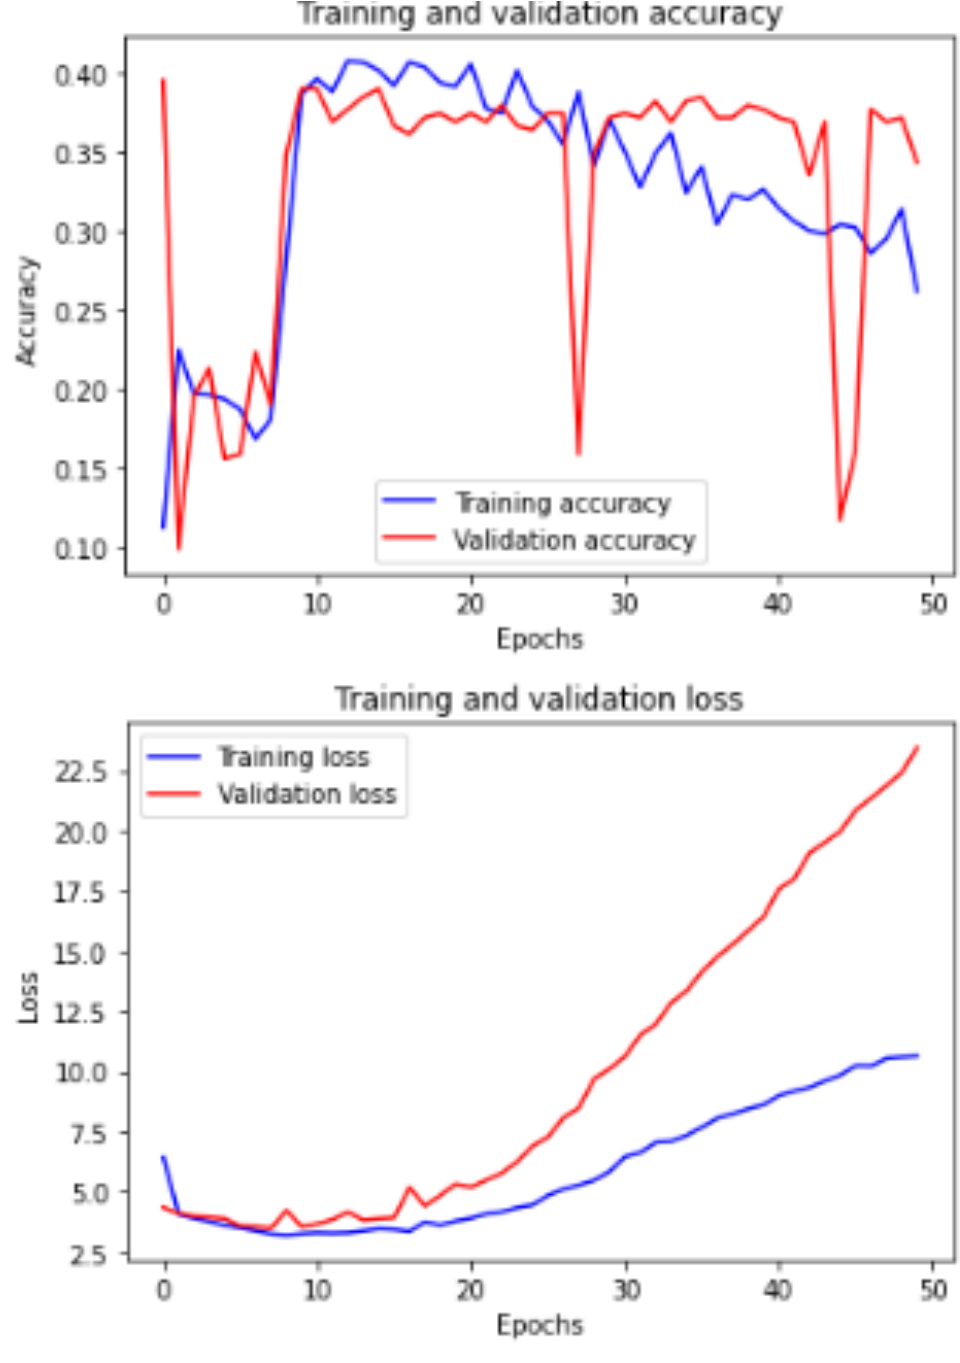
Figure 13. The training and validation ACC and loss through 50 epochs of the DenseNet201